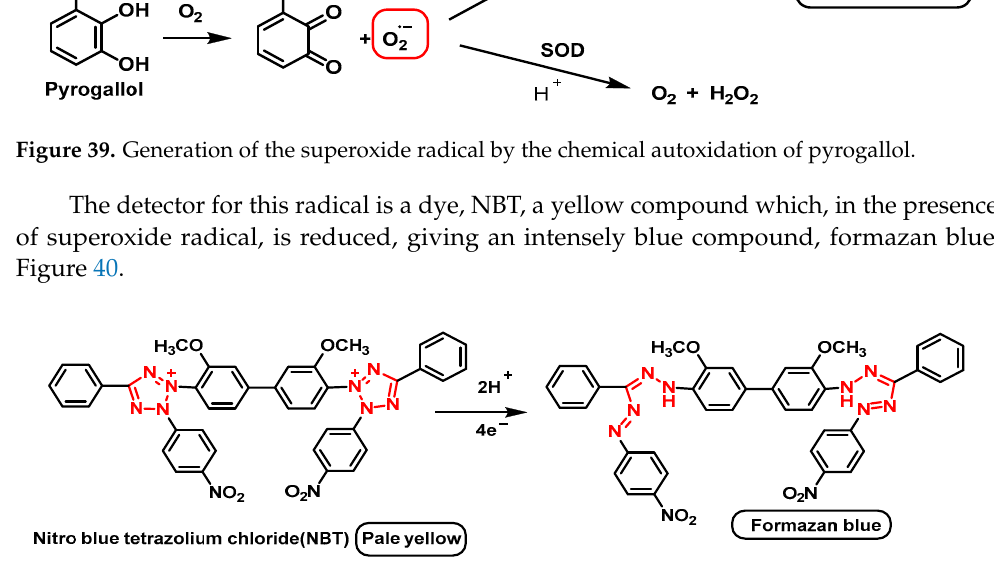
Figure 40. The reduction of NBT gives a compound with an intense blue colour, formazan